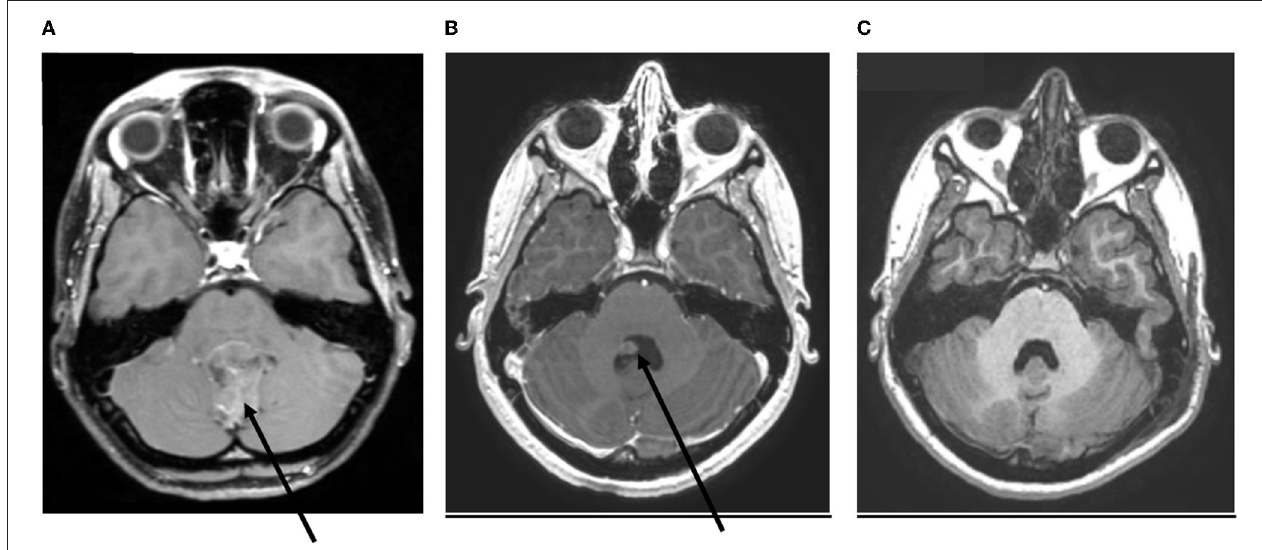
FIGURE 2 | Imaging of one patient with ependymoma, at different times. (A) At diagnosis. (B) Immediate postoperative imaging. (C) Postoperative imaging after second-look